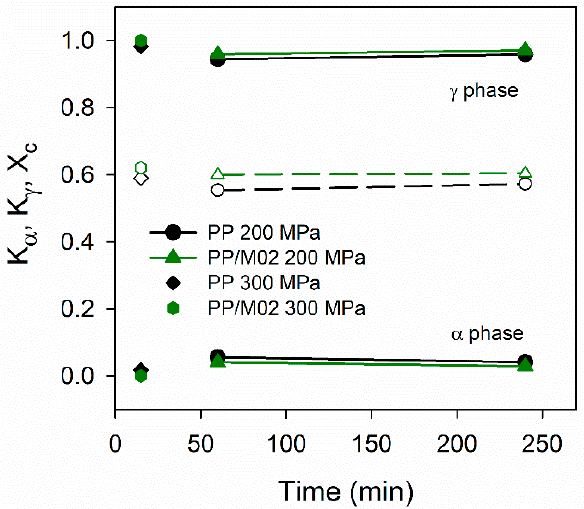
Figure 7. Phase contents in crystalline phase, K α and K γ (solid lines, filled symbols), and crystallinity degree, X c (dashed lines, empty symbols), of neat PP and PP/M02 crystallized according to protocol II vs. dwell time at 200 °C.